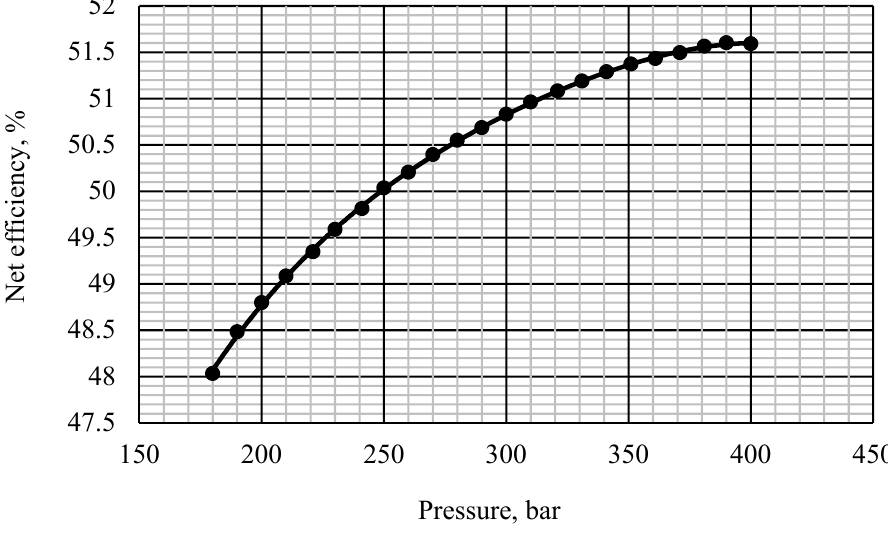
Figure 11. Dependence of the efficiency of the combined cycle on the pressure in the carbon dioxide turbine of the second cycle.